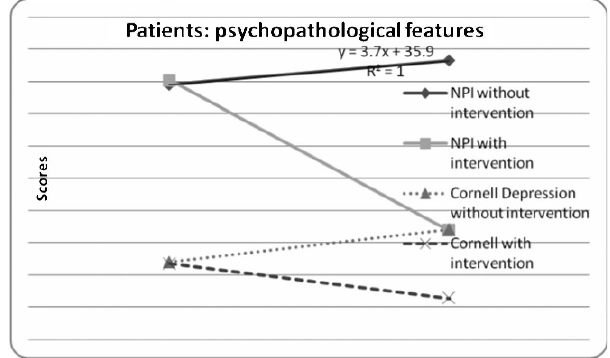
Figure 2 - Impact of motor intervention program on psycho- pathological features according to Neuropsychiatric Inventory and Cornell Scale for Depression in Dementia among patients with Alzheimer’s